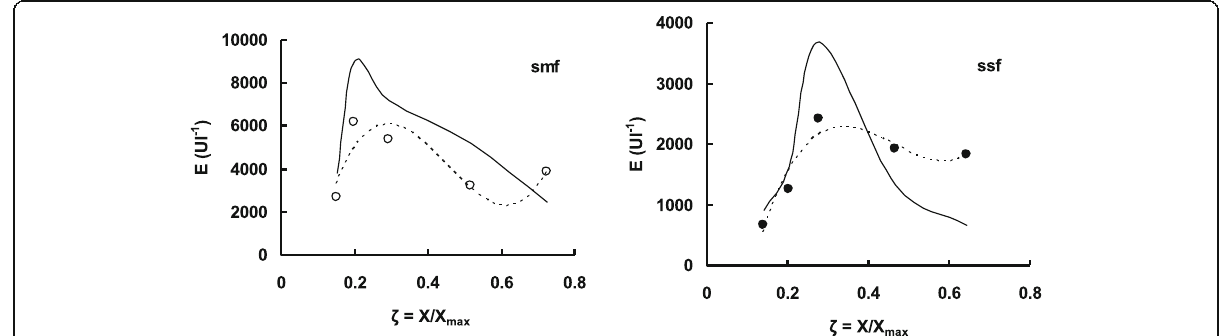
Fig. 3 Production trends of exo-polygalacturonase titers, E (Ul − 1 ) at a function of various levels of relative biomass production, ζ = X/X max in submerged ( ○ ) or solid-state fermentation ( ● ) of P. ostreatus . Symbols correspond to the experimental data and solid line ( − ) correspond to the calculated values by the Luedeking and Piret model together with the logistic equation, broken lines ( … ) represent the best-fitted line for smf ( y